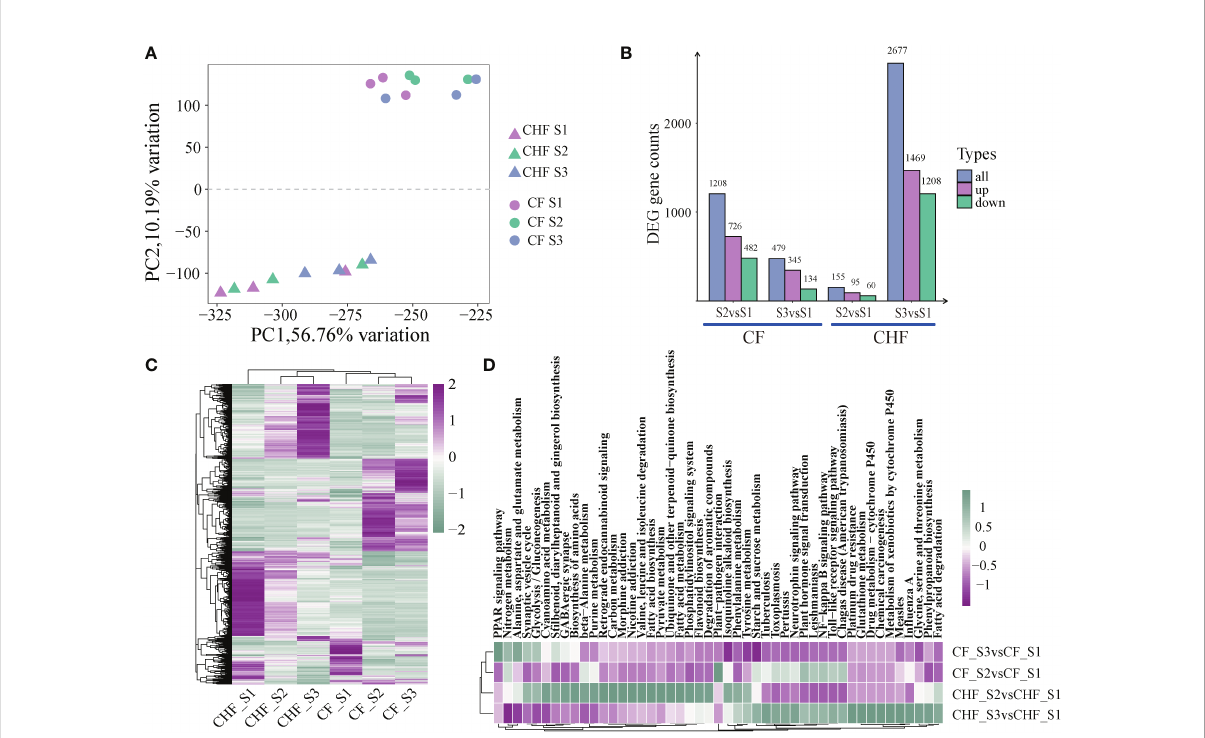
FIGURE 2 An overview of the RNA-seq data for CF and CHF during the S1, S2, and S3 phases. (A) PCA of RNA-seq data showed differences in lines and stages. (B) The number of DEGs during different stages for CF and CHF. (C) Heatmap showing the global expression of all DEGs. (D) KEGG enrichment analysis fi ndings of DEGs among various grouped comparisons, with each hue representing the normalized -log10 value